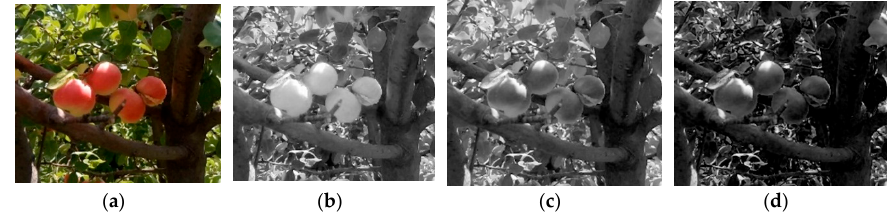
Figure 3. Sample apple tree image and RGB channels. ( a ) Original RGB image. ( b ) R channel. ( c ) G channel. ( d ) B channel.